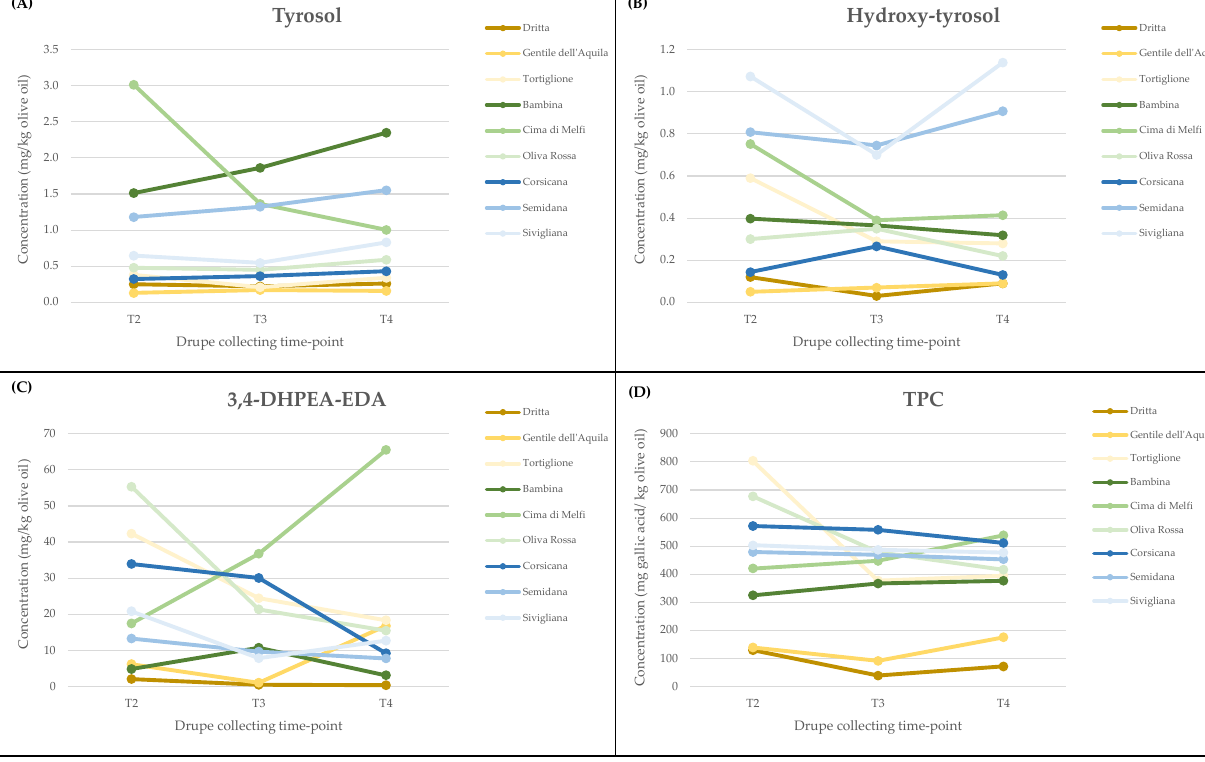
Figure 2. Trend of variation in some polyphenolic compound contents in VOOs of the analyzed genotypes, during three developmental stages of olive fruits (T2, T3, T4). ( A ) Tyrosol; ( B ) hydroxy-tyrosol; ( C ) oleacein (3,4-DHPEA-EDA); ( D ) total phenol content (TPC).